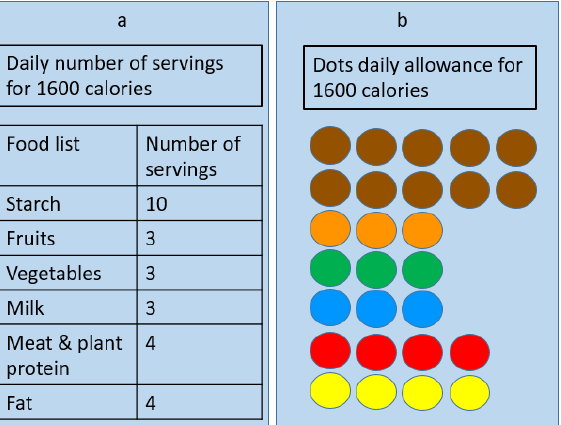
Figure 2. One-day diet plan to achieve 1600 calories. ( a ) Presents the recommended number of serv- ings from participants in group and ( b ) presents the color-coded dots participants needed to assem- ble by matching the equivalent dots attached to each food